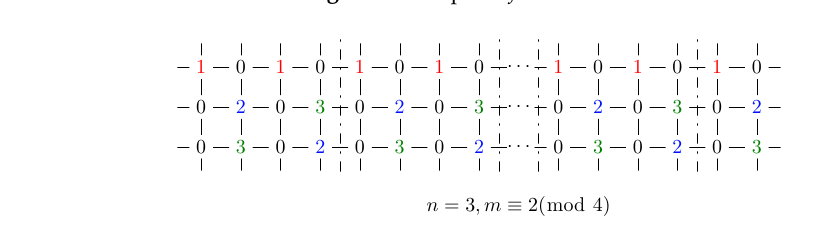
Figure 14. Graph of f in Case 4.2.2